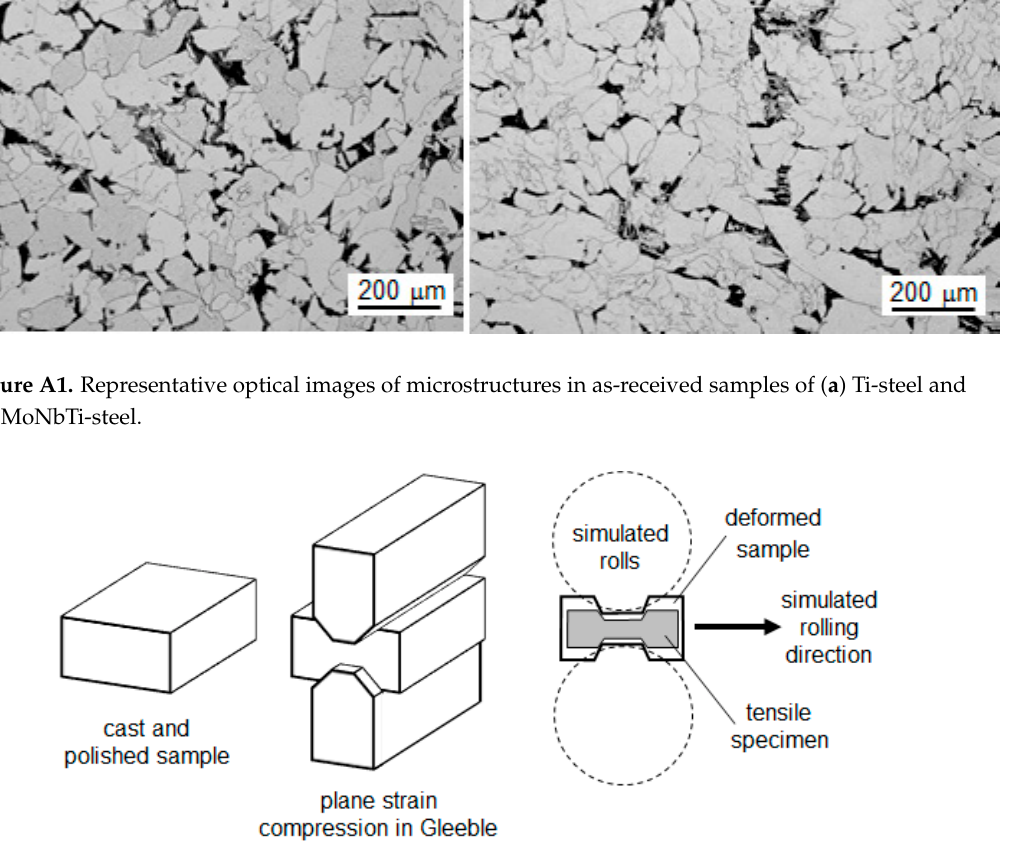
Figure A2. Scheme of Gleeble simulation of the rolling process.